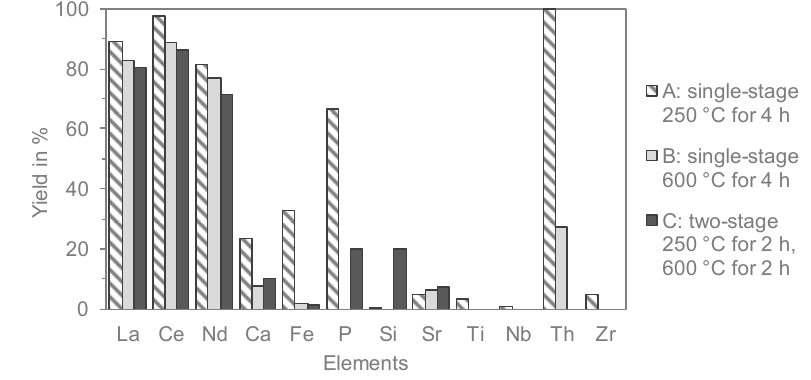
9 of 23 Figure 5. Backscattered electron micrograph (BSE(Z)) of the mineral phase containing up to 10.4 wt% thorium. 4.2. Digestion and Leaching 4.2.1. Preliminary Tests In preliminary tests, the sulfuric acid and the caustic soda digestion were compared to select a preferable method before optimizing the processing conditions.